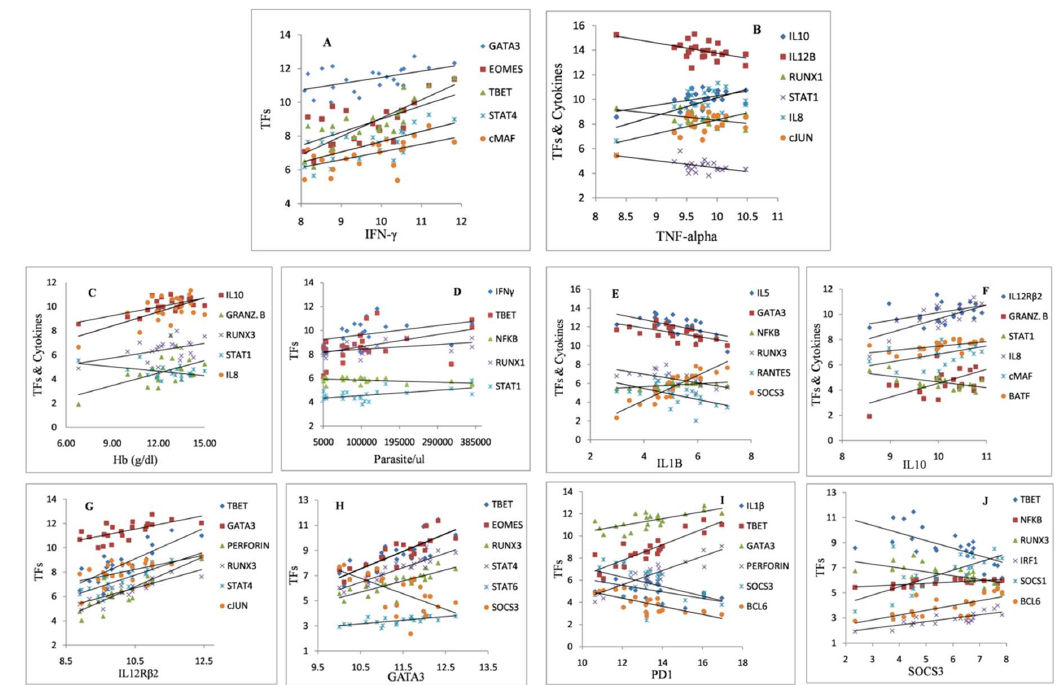
Figure 6. Pearson correlation statistical tests were performed to assess the correlation between cytokines, transcription factors, parasitemia and hemoglobin in all malaria sub-groups (UC1 + UC2 + SM). ( A ) r = 0.512, 0.656, 0.831, 0.658, 0.561, p = 0.015, 0.001, 0.000, 0.001, 0.007 ( B ) r = 0.519, −0.509, −0.454, −0.551, 0.571, 0.542, p = 0.013, 0.016, 0.034, 0.008, 0.005, 0.009 ( C ) r =0.669, 0.504, 0.442, −0.455,